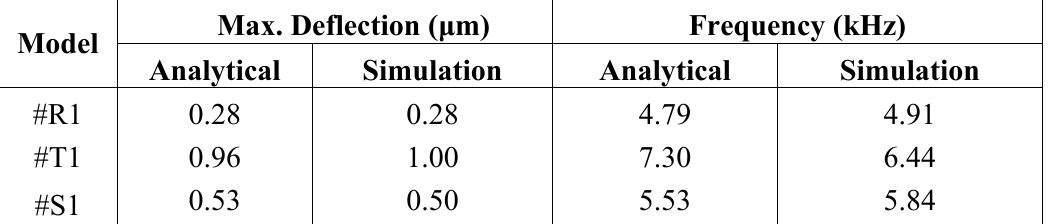
Table 1. Comparison between analytical and simulation results for basic rectangular, triangular, and step